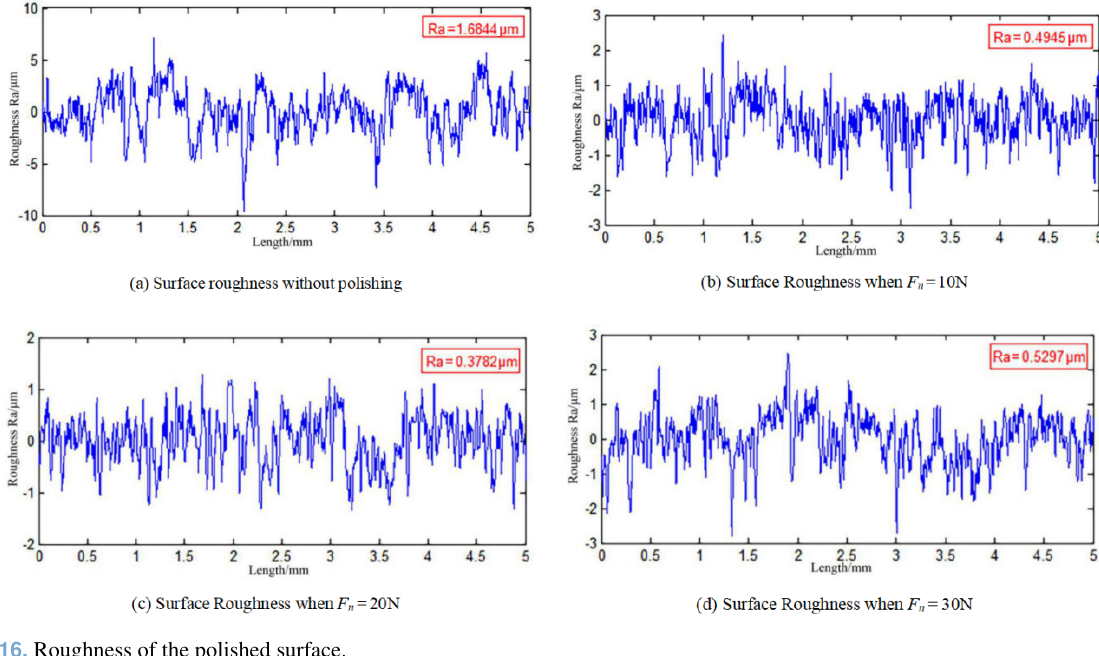
Figure 16. Roughness of the polished surface.